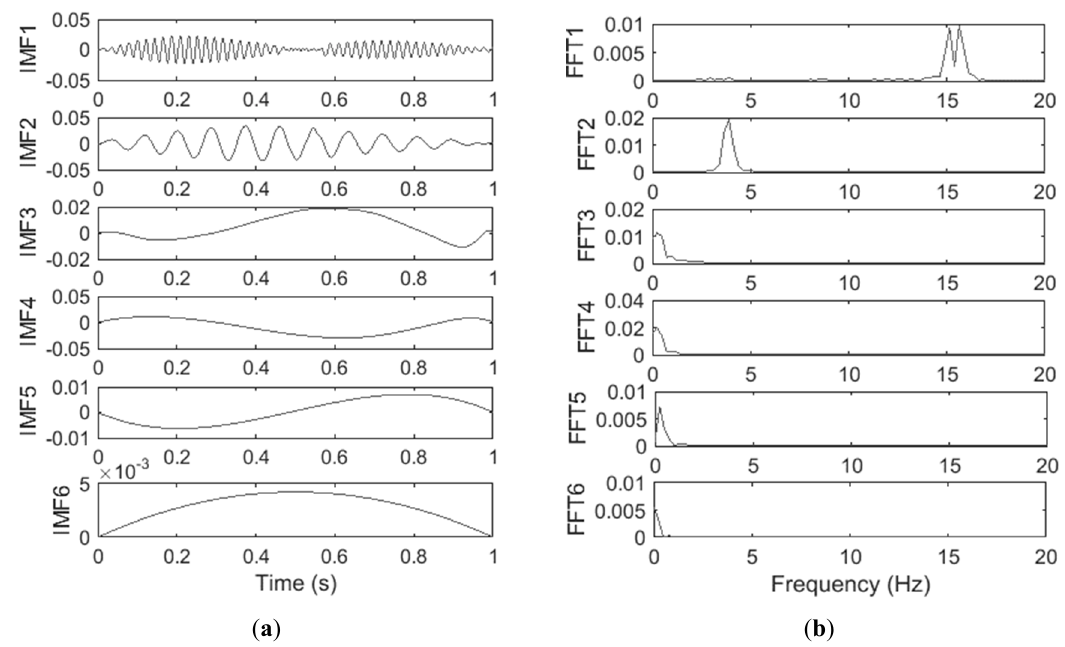
Figure 5. ( a ) Intrinsic mode functions (IMFs) of the vehicle acceleration response and ( b ) FFT spectra of the IMFs of the vehicle acceleration response.